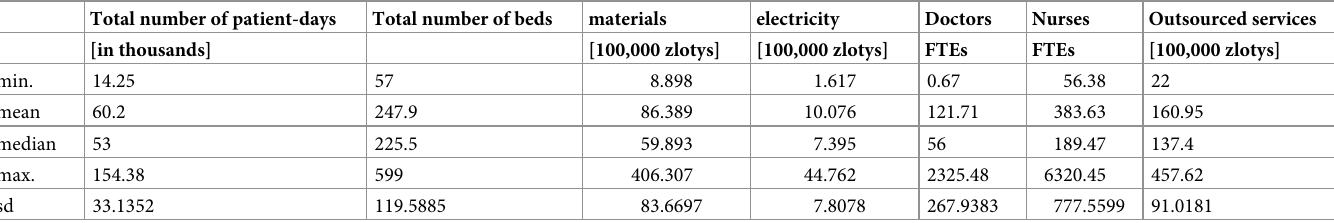
Table 1. Descriptive statistics for the analysed